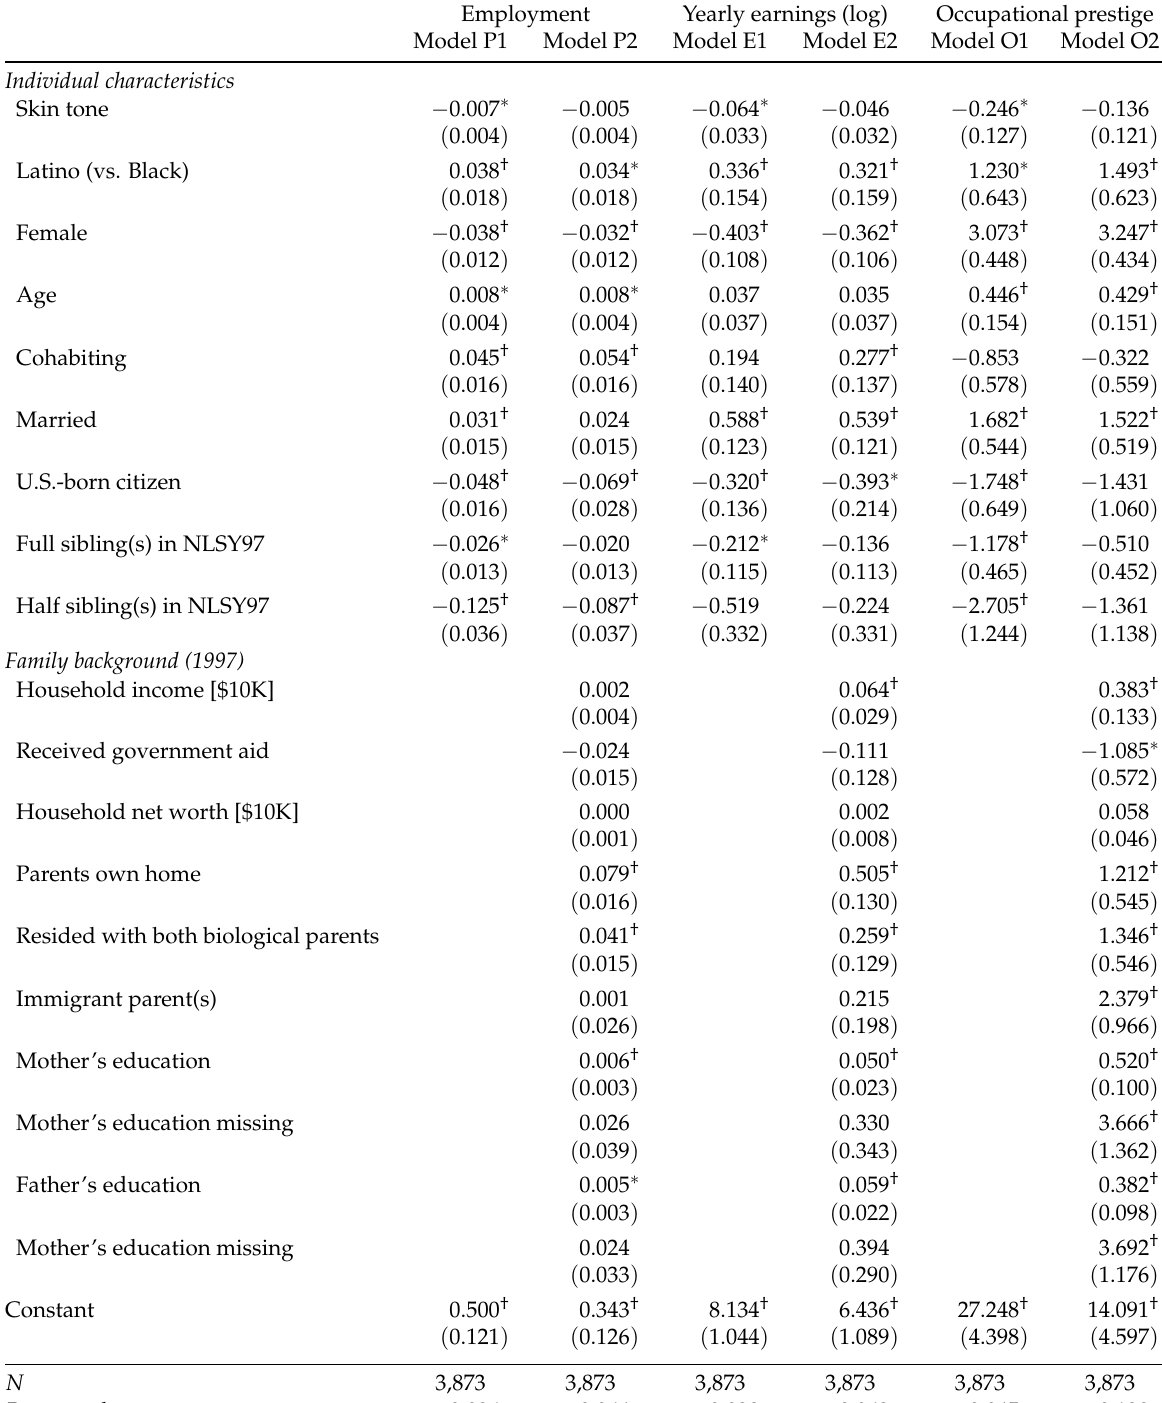
Table 1: Labor market outcomes by skin tone, covariates: Blacks and Latinos with full or half siblings in